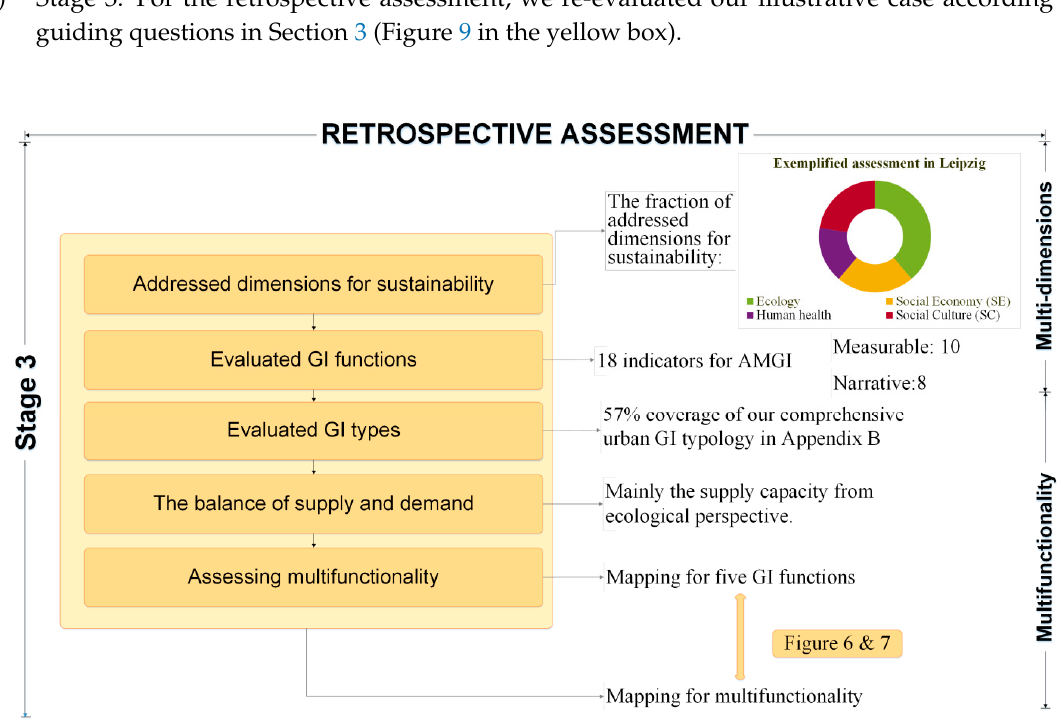
Figure 9. The results of Stage 3 exemplified in Leipzig.